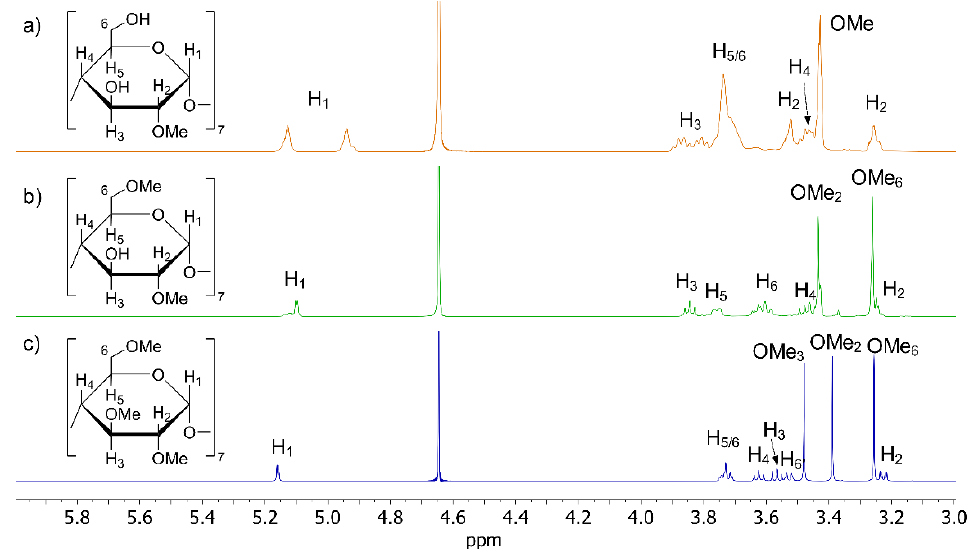
Figure 4. 1 H NMR (600 MHz, K 2 HPO 4 /D 2 O 50 mM, 25 °C, 12 mM) spectra of: ( a ) MCD, ( b ) DIMEB, and ( c ) TRIMEB.